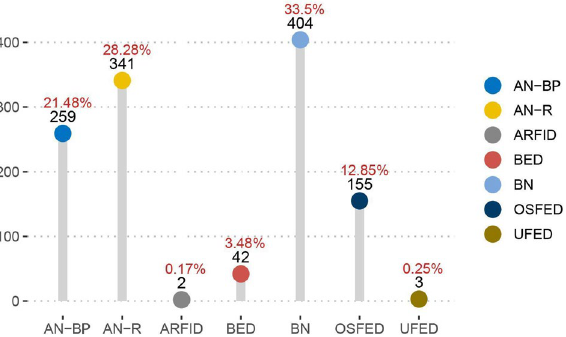
Figure 1. Frequency of different DSM-5 diagnoses for EDs in the sample collected by Brookings (2020) 15